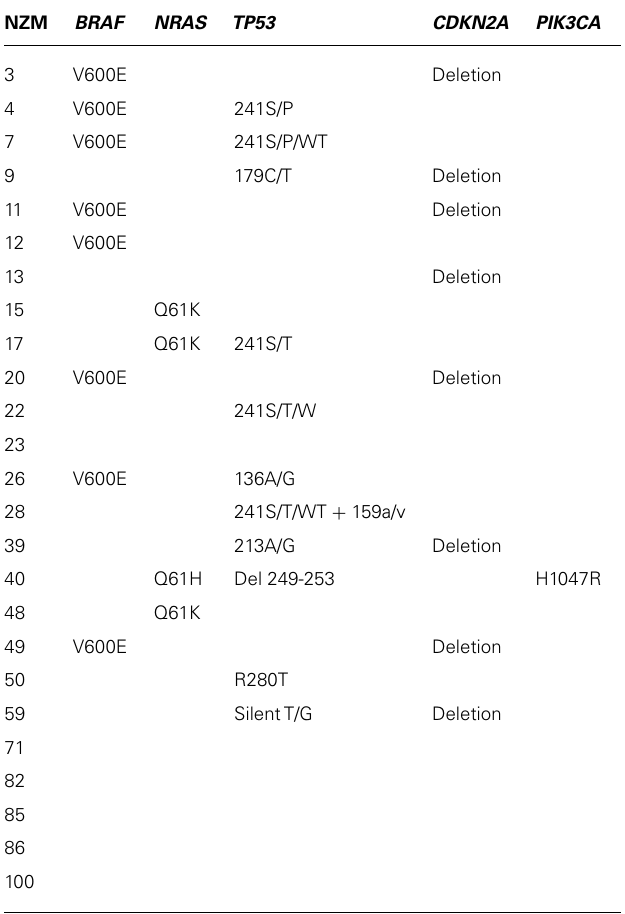
Table 1 | Genetic status of the melanoma lines used in this